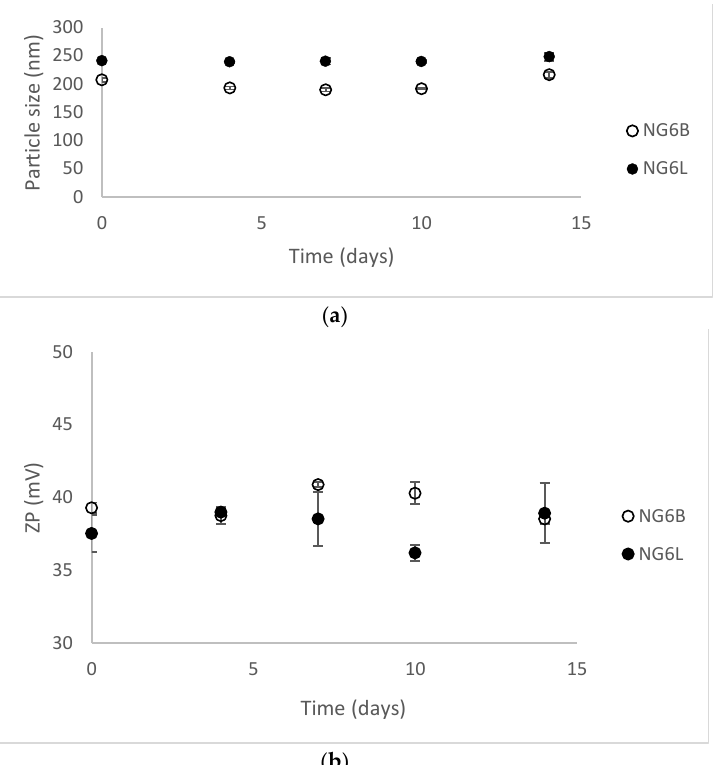
Figure 2. Stability results at 4 °C for 14 days in terms of dimensions ( a ) and ZP values ( b ) (mean ± sd, analysis in triplicate on single batch).